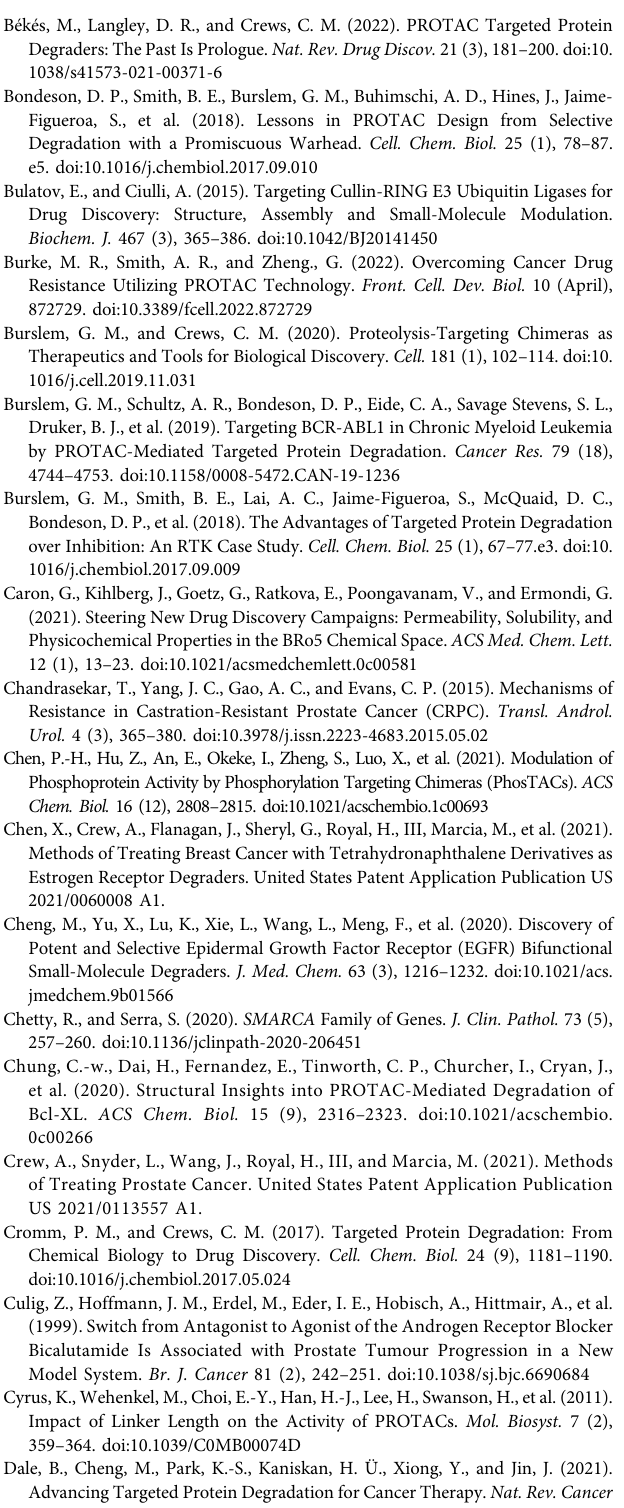
Figueroa, S., et al. (2018). Lessons in PROTAC Design from Selective Degradation with a Promiscuous Warhead. Cell. Chem. Biol. 25 (1), 78 –